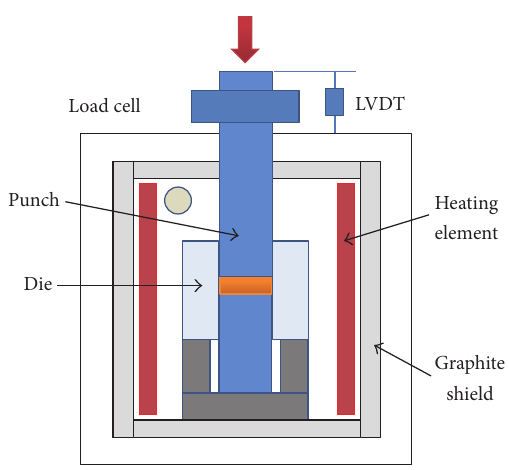
Figure 2: Schematic drawing of the hot press apparatus.